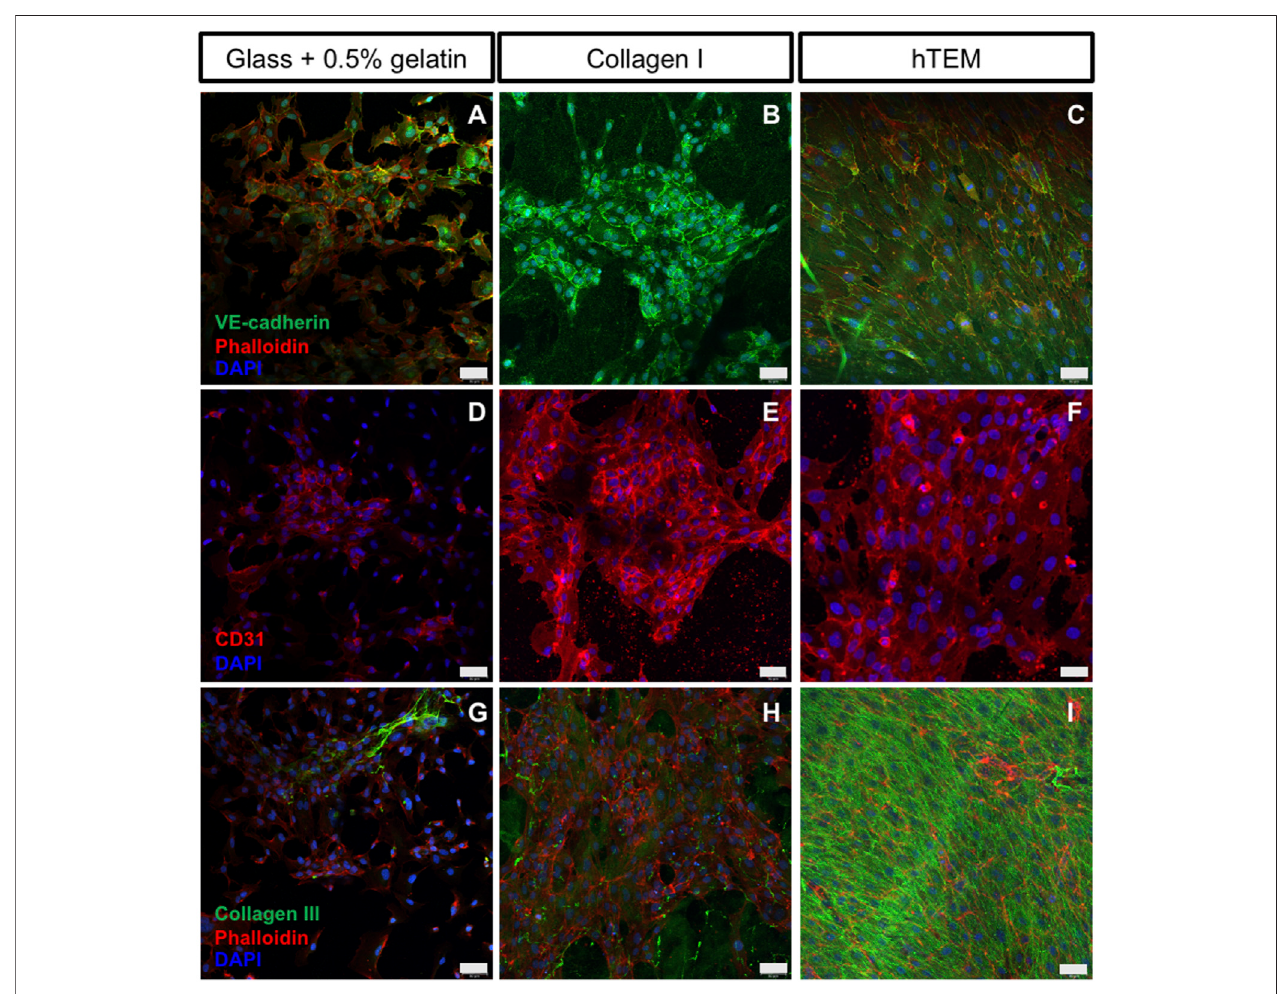
FIGURE2| ConfocalimagesofECFCsculturedongelatin-coatedglass,collagenIgels,andhTEMsat5 days. (A – C) :ECFCsstainedforVE-cad(green),phalloidin (red), and DAPI (blue). (D – F) : ECFCs stained for CD31 (red) and DAPI (blue). (G – I) : Staining for Collagen III (green), phalloidin (red), and DAPI (blue). (A,D,G) : glass coveredwith0.5%gelatinshowlimitedpre-endothelializationpotentialwithpoorECFCscon fl uencyafter5 daysofculture,limitedcell-cellcontact,andlowexpressionof CD31 and VE-cad. (B,E,H) : Collagen I gel show spot-dependent pre-endothelialization. ECFCs are organized in colonies with presence of cell-cell contacts and expression of CD31 and VE-cad. (C,F,I) : ECFCs seeded onto hTEM substrates demonstrate good pre-endothelialization potential, by achieving complete con fl uency after 5 days of culture (50 µm scale bars).